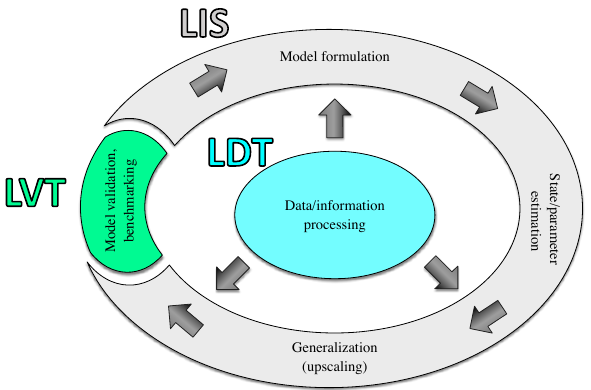
Figure 1. Schematic of the complete model–data fusion (MDF) paradigm enabled by LDT, LIS, and LVT (modeled after Fig. 1 in Williams et al., 2009). LDT is the data preprocessing environment that feeds into the modeling and data assimilation environment of LIS and also LVT (the model evaluation and benchmarking